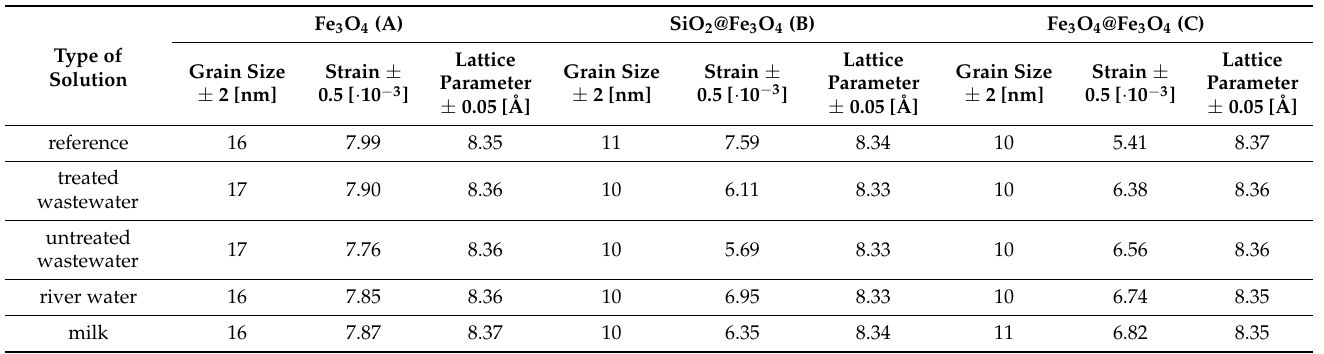
Table 2. Estimated average grain sizes, lattice parameters, and strain of wetted nanoparticles determined by X-ray diffraction